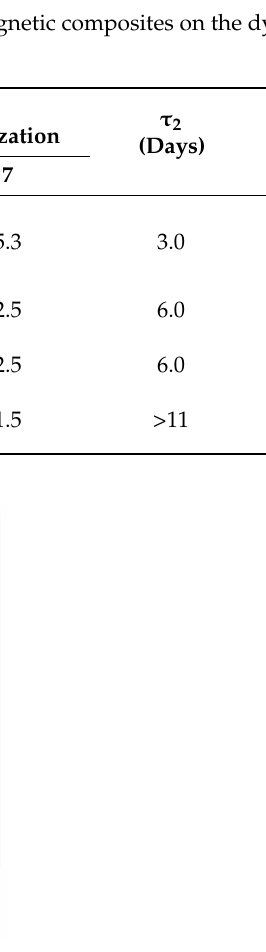
Figure 20. Inhibition of rat liver tumor growth after embolization of tumor vascular system by silicone-based magnetic composites: 1: test group; 2: embolization with composite I (administrative dose 0.1 mL); 3: embolization with composite II (administrative dose 0.2 mL); standard deviation is ±0.5. Table 5. The effect of embolization by silicone-based magnetic composites on the dynamics of PC1 tumor growth in rats.